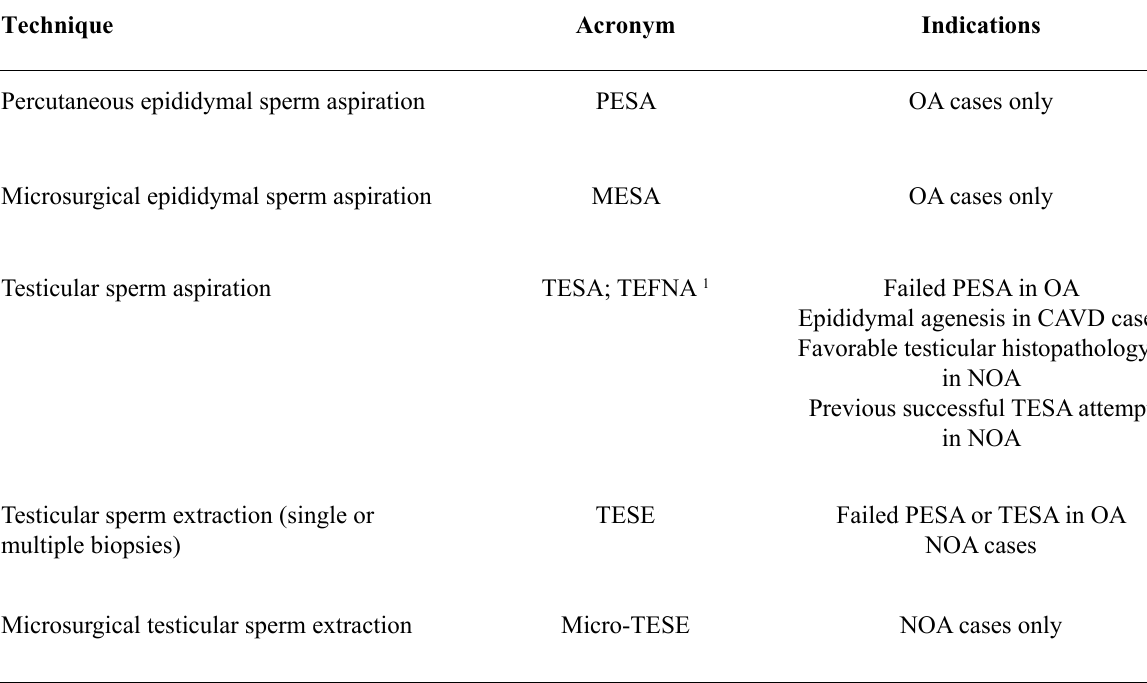
Table 1 - Sperm Retrieval Techniques and their Indications for Assisted